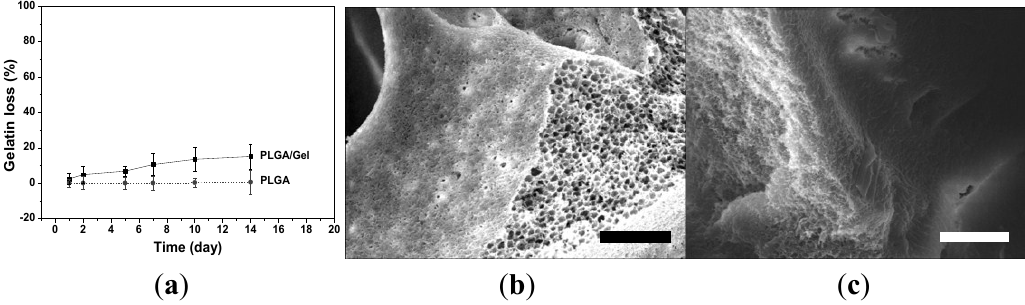
Figure 4. Gelatin leaching kinetic of coated scaffold ( a ); SEM microimages of PLGA scaffold ( b ); and PLGA scaffold with gelatin coating ( c ). Scale bar = 30